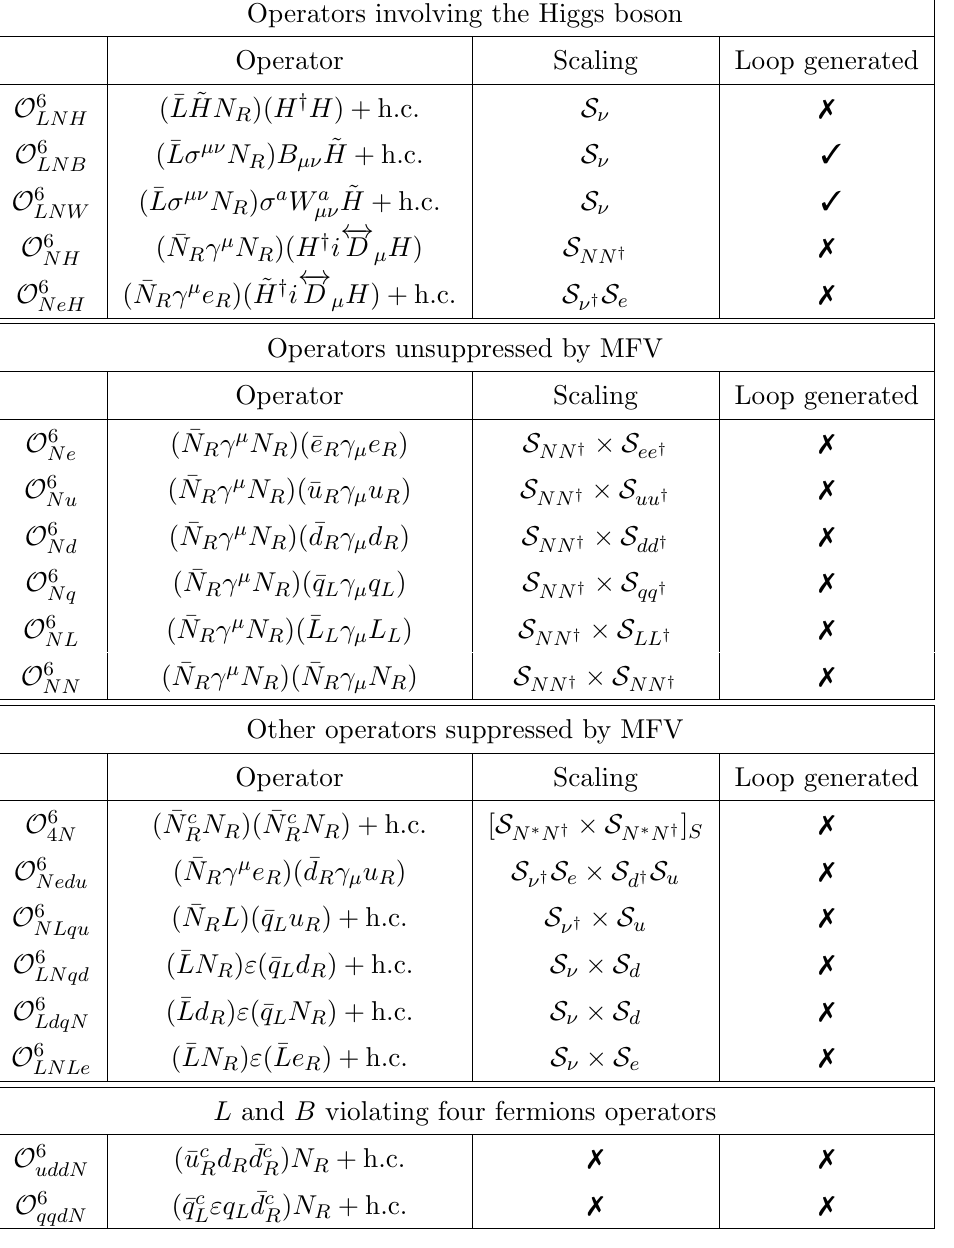
Table 3 . Dimension six operators involving a RH neutrino N R [37]. We also show the scaling of the Wilson coe(cid:14)cients in terms of the spurions of eq. (3.7), eq. (3.8) and eq. (3.9), and if they are generated at one loop in a general UV completion. The classi(cid:12)cation is useful in the discussion of the phenomenological implications of MFV, see sections 6 and